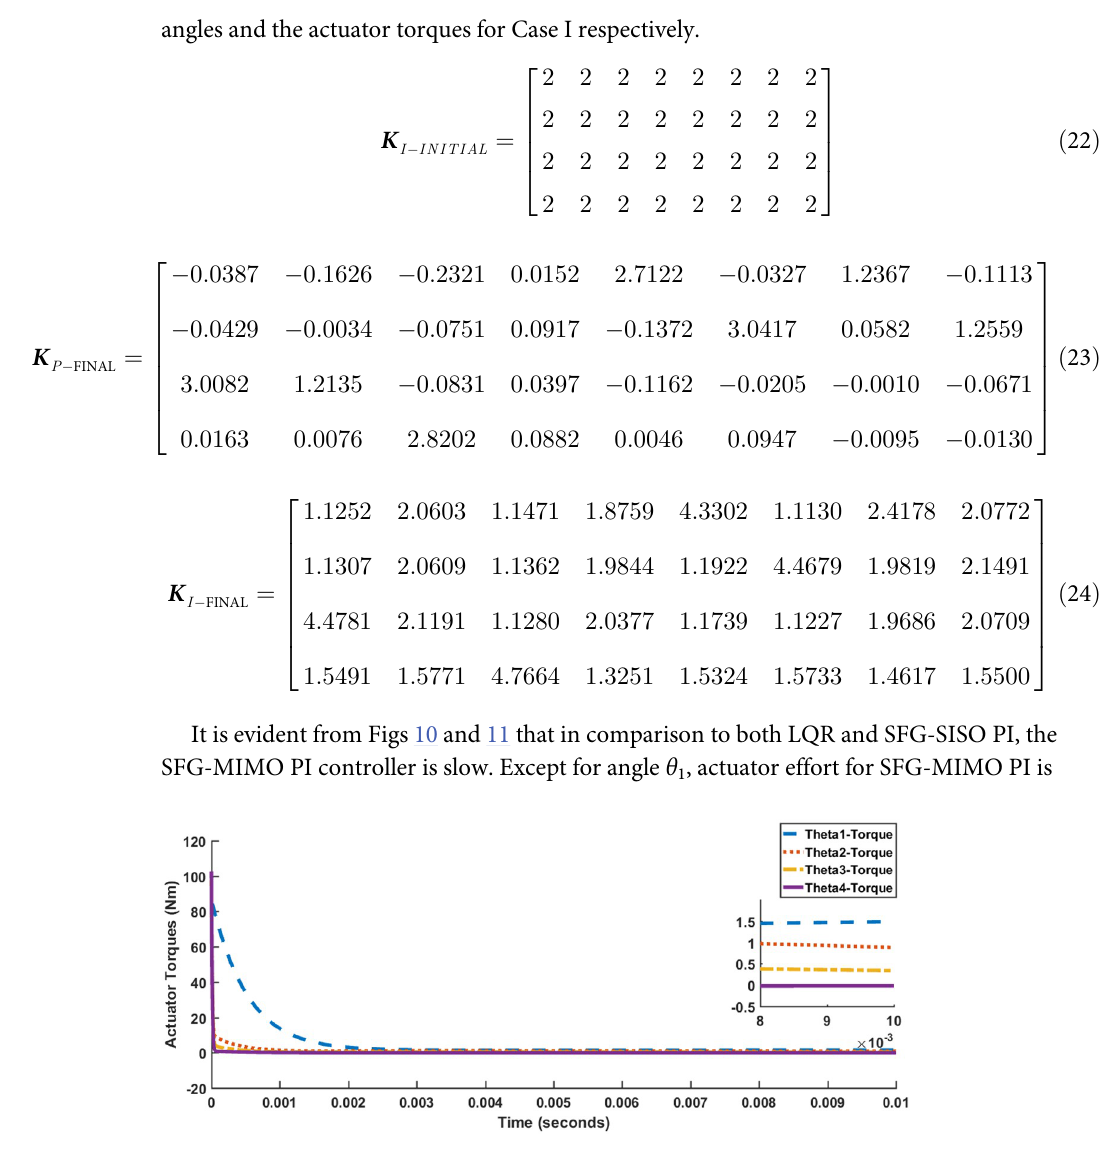
Fig 11. SFG-MIMO PI actuator response, Case